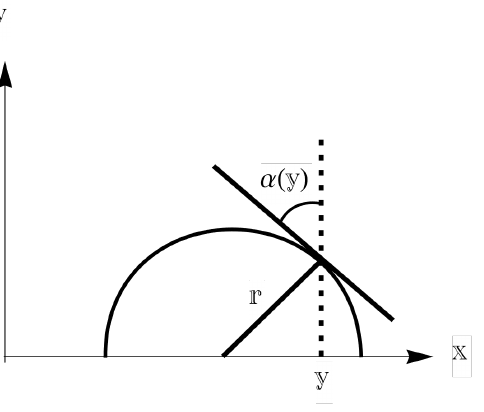
Figure 1. Physical basis of the Poincaré